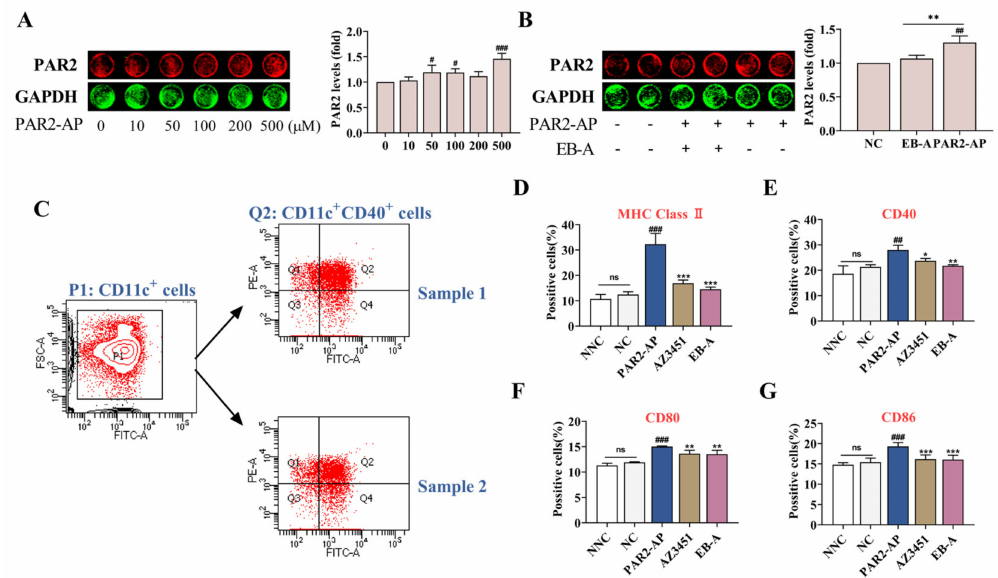
Figure 7. EB-A prevents DCs maturation by inhibiting PAR2 activation in vitro. ( A ) In-cell Western blot was used to evaluate the effects of different concentrations of PAR2-AP on the expression of PAR2 in 16HBE cells. ( B ) The effect of EB-A on PAR2 expression in 16HBE cells was estimated by in-cell Western blot. ( C ) Logic diagram of flow gate, taking CD40 as an example. ( D ) The levels of MHC Class II on the surface of BMDCs in the co-culture system were detected by FCM. ( E ) The levels of CD40 on the surface of BMDCs in the co-culture system were detected by FCM. ( F ) The levels of CD80 on the surface of BMDCs in the co-culture system were detected by FCM. ( G ) The levels of CD86 on the surface of BMDCs in the co-culture system were detected by FCM. All data are shown as mean ± SD. # p < 0.05, ## p < 0.01, ### p < 0.001, compared with the NC group; * p < 0.05, ** p < 0.01, *** p < 0.001, compared with the PAR2-AP treated